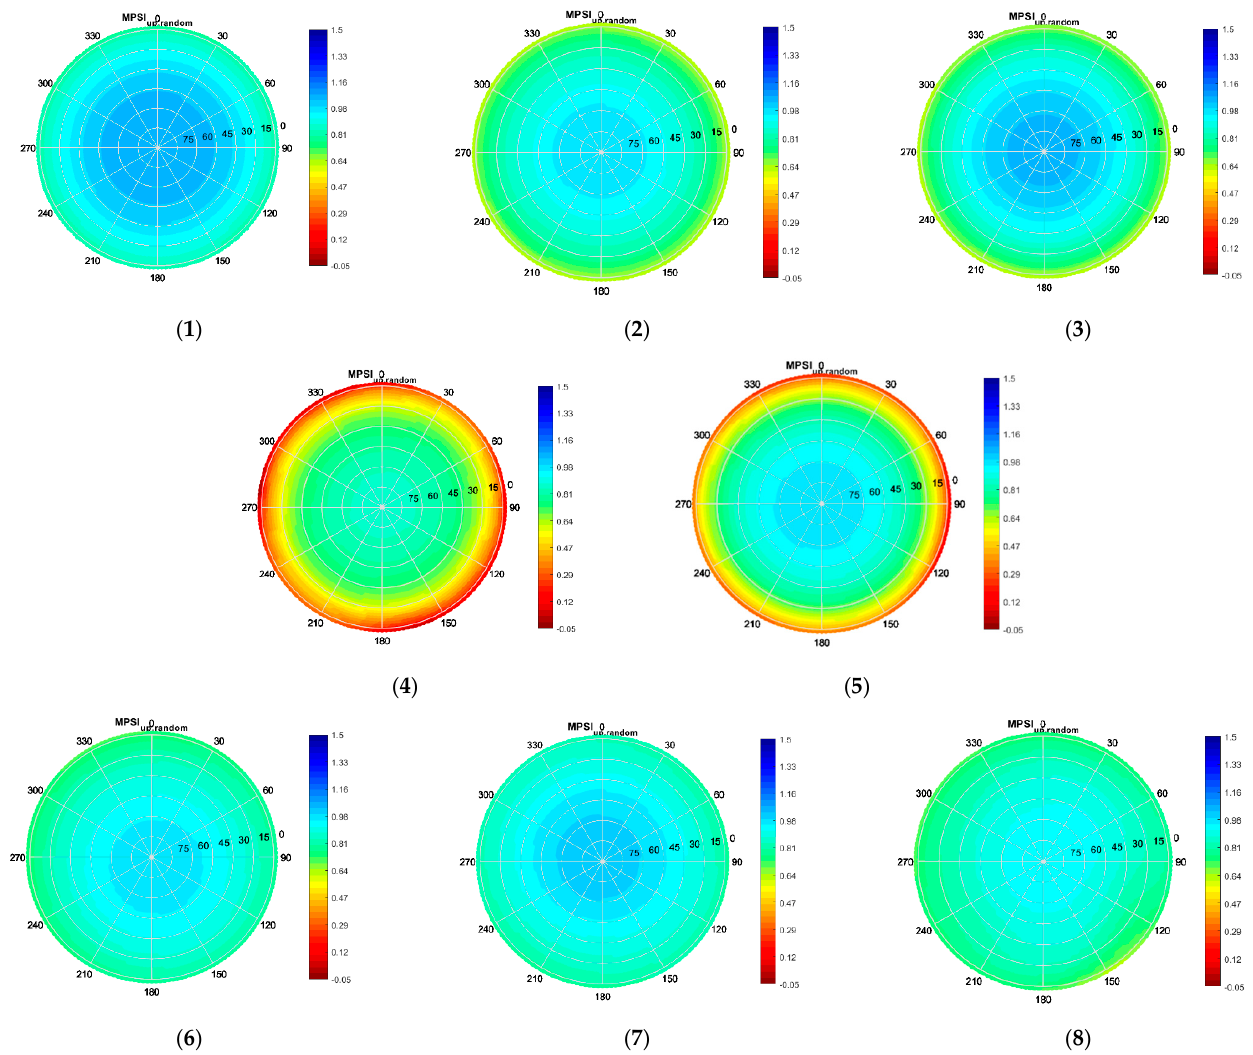
Figure A8. MPSI up at L5/E5a central frequency of the antennas measured at DLR; from left to right, from top to bottom: ( 1 ) Leica AR25 R4; ( 2 ) Novatel GNSS-750; ( 3 ) Javad RingAnt-DM; ( 4 ) Space Engineering GalExpAnt; ( 5 ) DLR internal design; ( 6 ) Novatel 703-GGG; ( 7 ) Navxperience Nav3G+C; ( 8 ) Tallysman VSE6028 VeroStar.